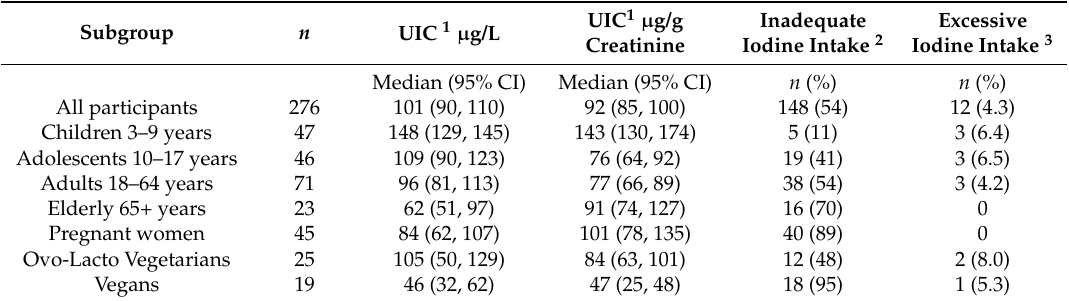
Table 2. Urinary iodine concentration (UIC) expressed as µ g/L and as µ g/g creatinine, in all participants combined and by non-overlapping subgroups.